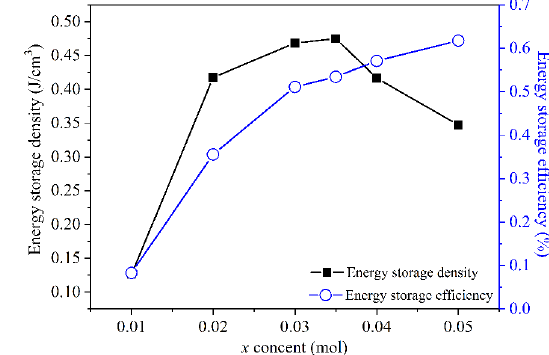
Figure 4. Energy storage density and efficiency of BNBT- x NT